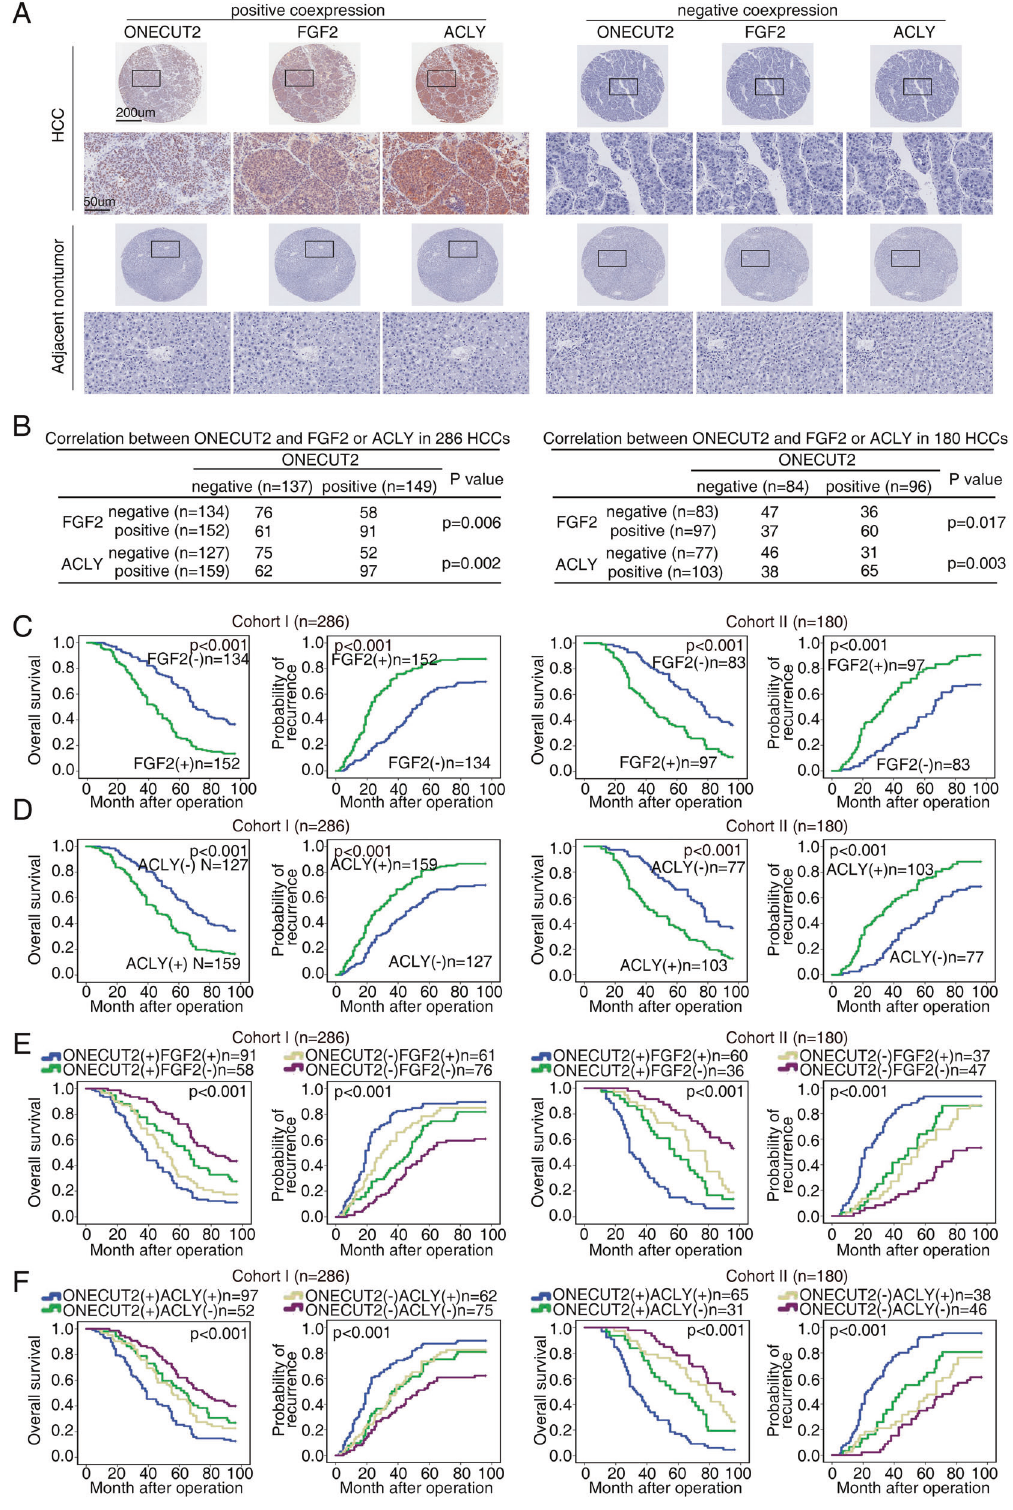
Fig. 3 ONECUT2 levels are positively correlated with FGF2 and ACLY levels in HCC tissues. A Representative IHC staining for ONECUT2, FGF2, and ACLY in HCC and adjacent nontumor tissues. B Correlation analyses of protein expression between ONECUT2 and ACLY or FGF2 in two HCC cohorts. C , D Prognosis of HCC patients was compared between negative and positive FGF2 expression group and between negative and positive ACLYexpression group by Kaplan – Meier method in two HCC cohorts. E , F Prognosis of HCC patients was compared based on the coexpression of ONECUT2 and ACLY or FGF2 by Kaplan – Meier method in two HCC cohorts.